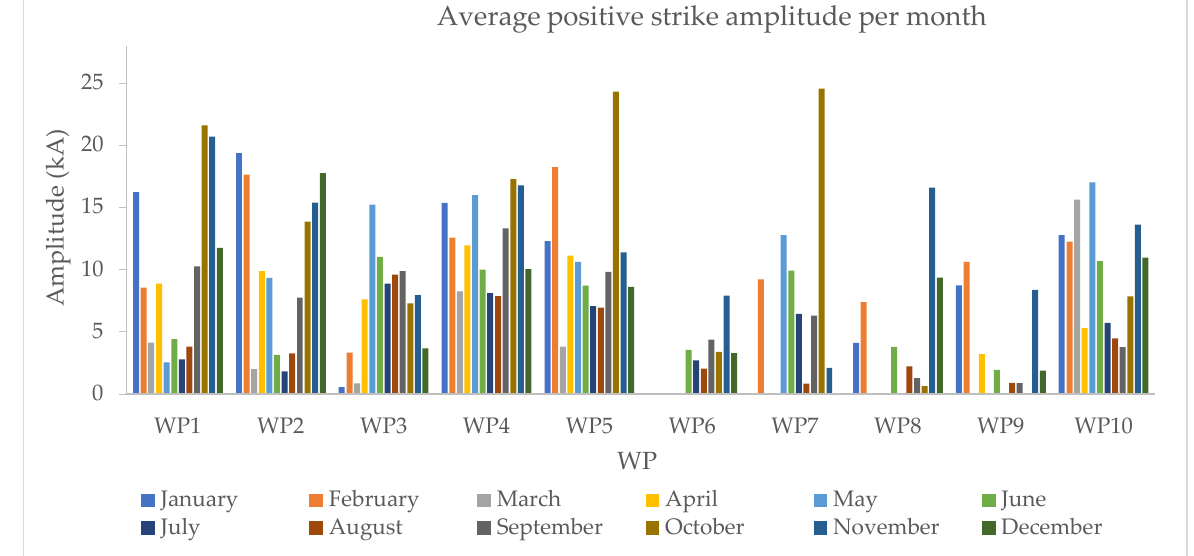
Figure 4. Monthly average amplitude (kA) of the recorded positive strikes of each wind park (observation period 2011–2020).